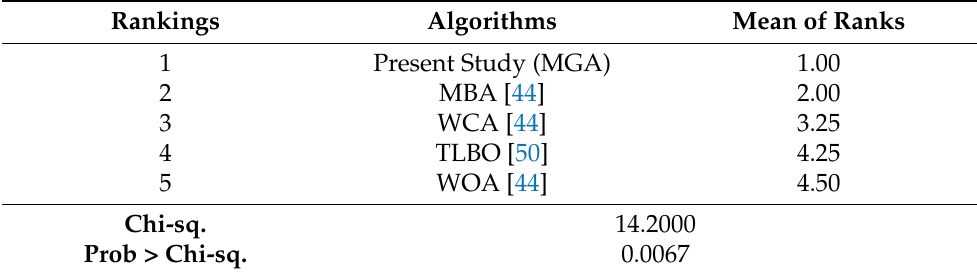
Table A16. Friedman statistical test results for the step-cone pulley design problem.